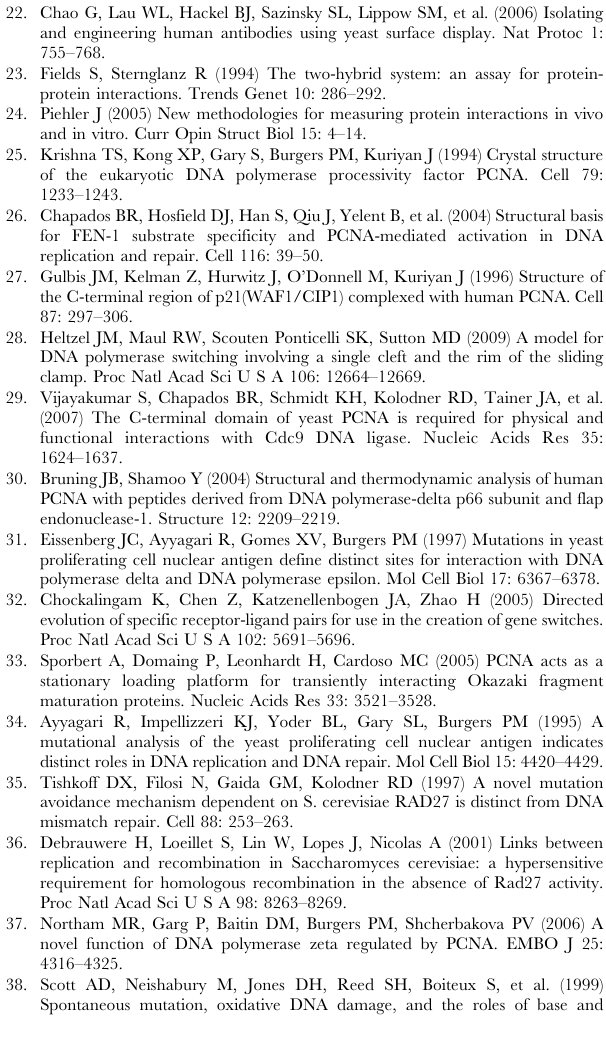
Figure S9 The effects of overexpression of Rad27, Rad30, Pol32, and Msh6 on the growth sensitivity of the POL30 , pol30 -79, pol30 -Rad27E6, or pol30 -Pol32E5 strain. Overexpression of the different partners did not reduce the growth sensitivity of the strains to DNA damaging agents. Table S1 Yeast two hybrid analysis of binding of selected PCNA mutants with seven additional partners not described in Table 1 of the main text.